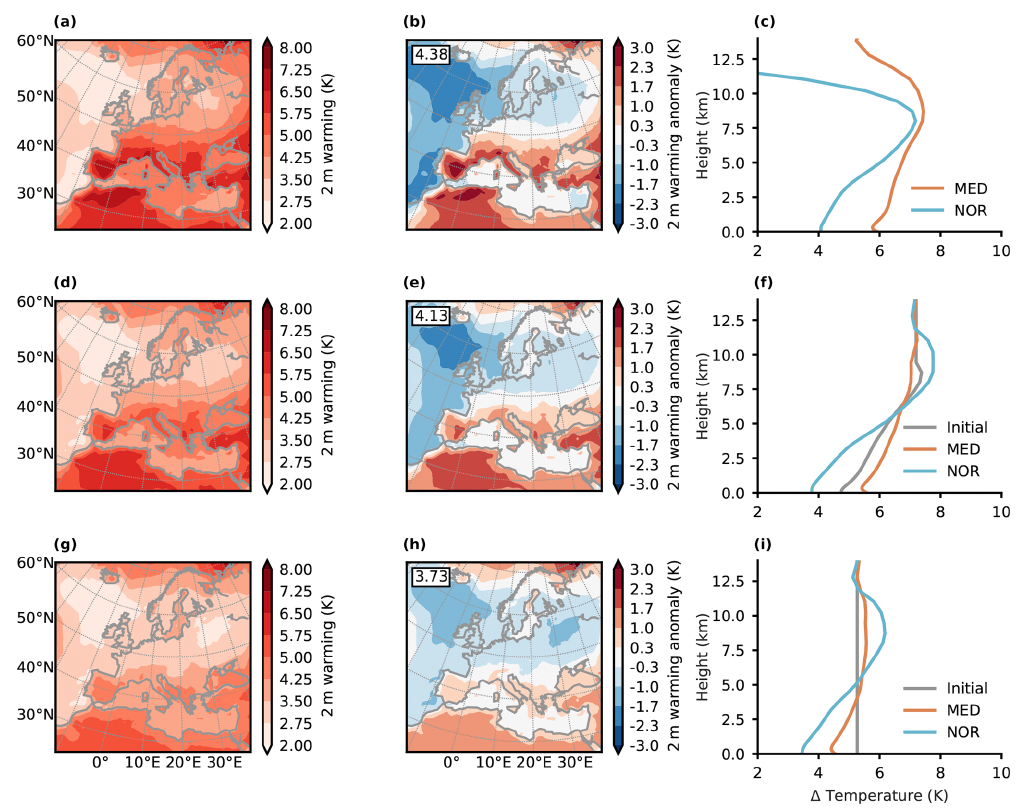
Figure 3. Idealized simulations demonstrating the importance of tropospheric lapse-rate changes for European surface summer (JJA) warm- ing anomalies. (a) Mean summer 2m warming for full climate change (FCC), which is the mean of two RCM simulations dynamically downscaling two different GCMs assuming RCP8.5. We assess the warming between 2070–2099 and 1971–2000. (b) Same as panel (a) but showing 2m warming anomaly (deviation from the domain mean given in the upper left of the map). (c) Mean vertical profiles of the summer temperature changes for the simulations shown in panels (a) and (b) for Mediterranean (orange line) land grid points (MED; between 30 and 44 ◦ N) and northern European (blue line) land grid points (NOR; between 55 and 70 ◦ N). (d–f) Same as in panels (a) – (c) but for TDLR, which is the mean of two idealized simulations, where the mean vertical warming profile as shown by the gray line in panel (f) is imposed on all lateral boundary grid points of the RCM simulations for 1971–2000. (g–i) Same as panels (d) – (f) but for TD that differs from TDLR by the imposed a vertically uniform warming profile shown by the gray line in panel (i)